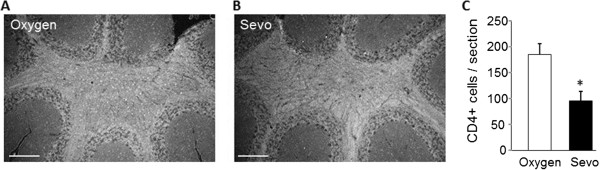
Sevoflurane reduces CD4+ T cells in the cerebellum of experimental autoimmune encephalomyelitis (EAE) mice. Representative sagittal sections from (A) oxygen-treated and (B) sevoflurane-treated mice were stained with antibody against the CD4 receptor to detect infiltrating T cells, which are visible as small cells staining throughout the white matter. (C) The total numbers of CD4+ cells per field of view were quantified. Data are mean ± SEM of n = 5 sections per animal, three mice per group; *P <0.05 versus oxygen. Scale bar is 500 μm.